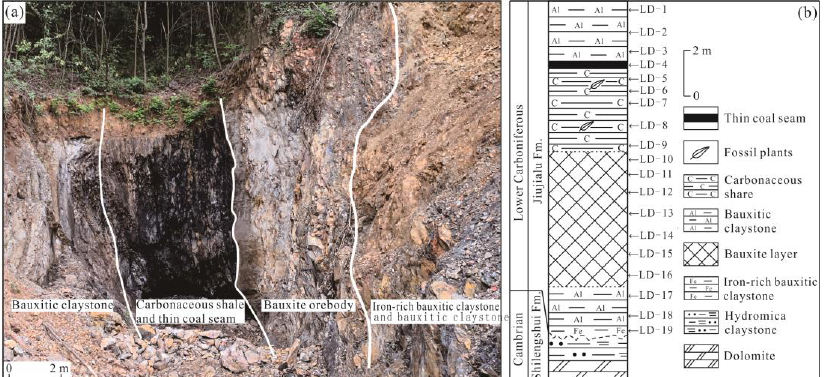
Figure 2. Paleozoic stratigraphic sequences in central Guizhou area (modified from [28]).